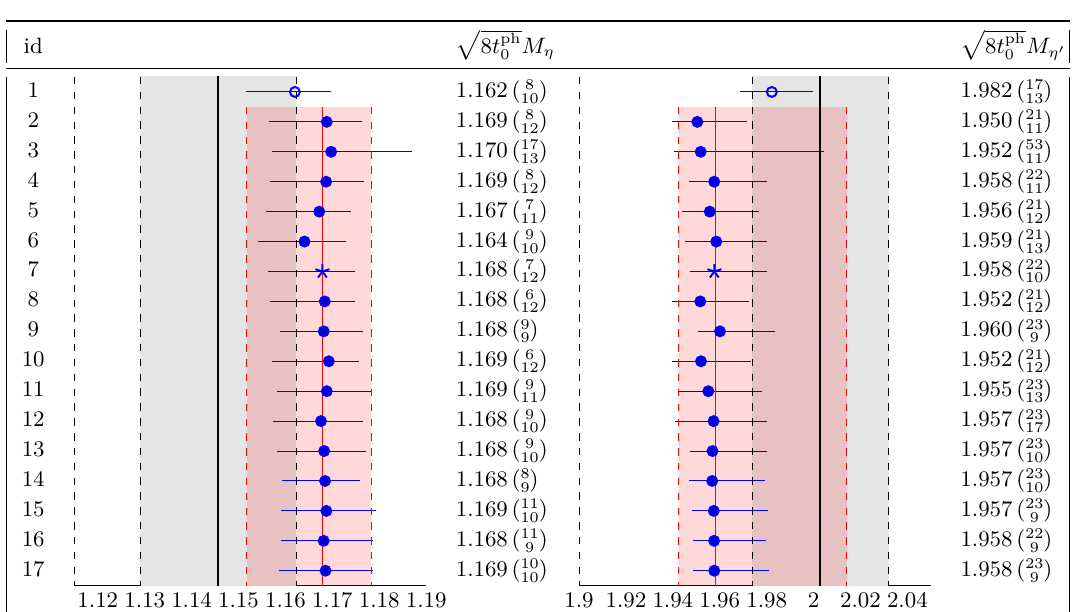
) − 1 / 2 = 475(6) MeV [49] 0 . The red line indicates the 0